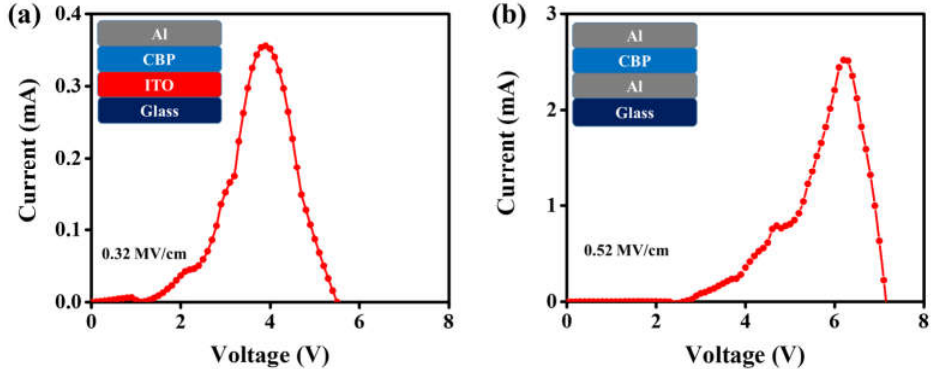
Figure 3. Current-Voltage (I-V) characteristics of the devices having 120 nm CBP layer with ( a ) ITO/CBP/aluminum (Al) and ( b ) Al/CBP/Al device structures.